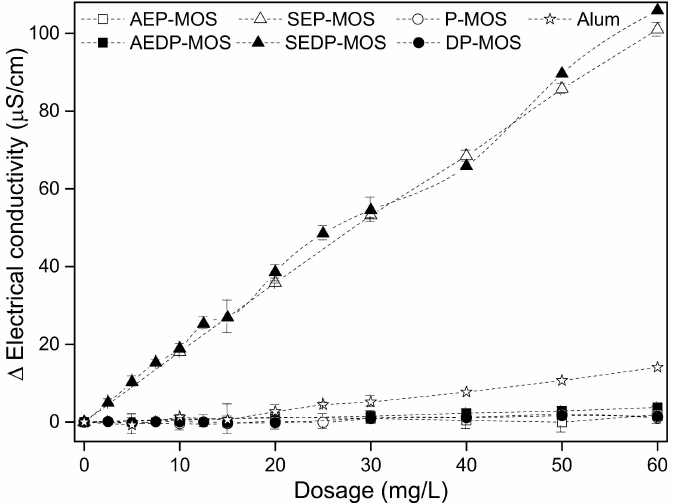
Figure 5. Electrical conductivity variation as a function of Moringa oleifera seed-derived and alum coagulants dosages in jar tests after coagulation, flocculation, and sedimentation. Initial conductivity was 49.1 ± 4.4 µ